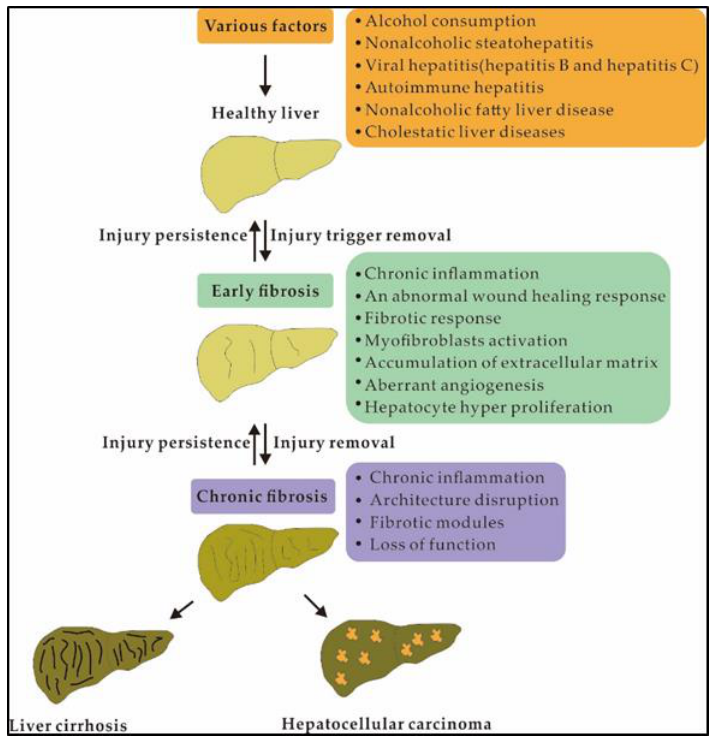
Figure 1. Pathogenesis of liver fibrosis. 45